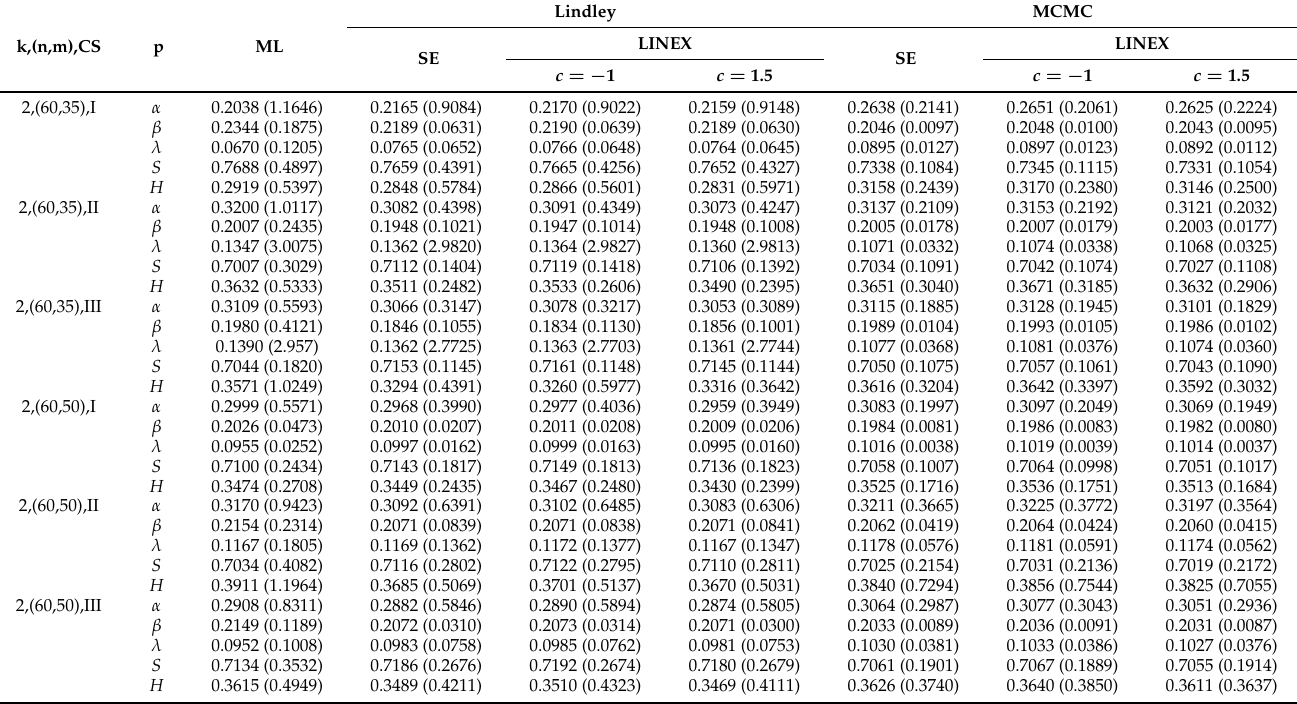
Table 2. AM and (MSE) of estimates for α , β , λ , S , and H